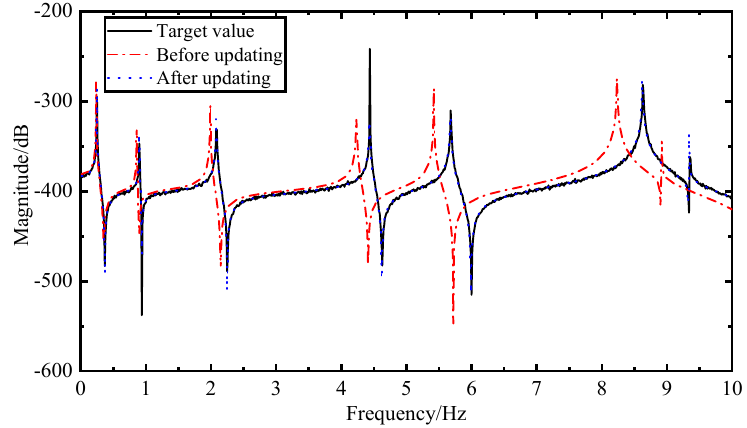
Figure 11. Comparison of FRFs data measured at Node 13 under 5% random white noise. Appl. Sci. 2020 , 10 , x FOR PEER REVIEW